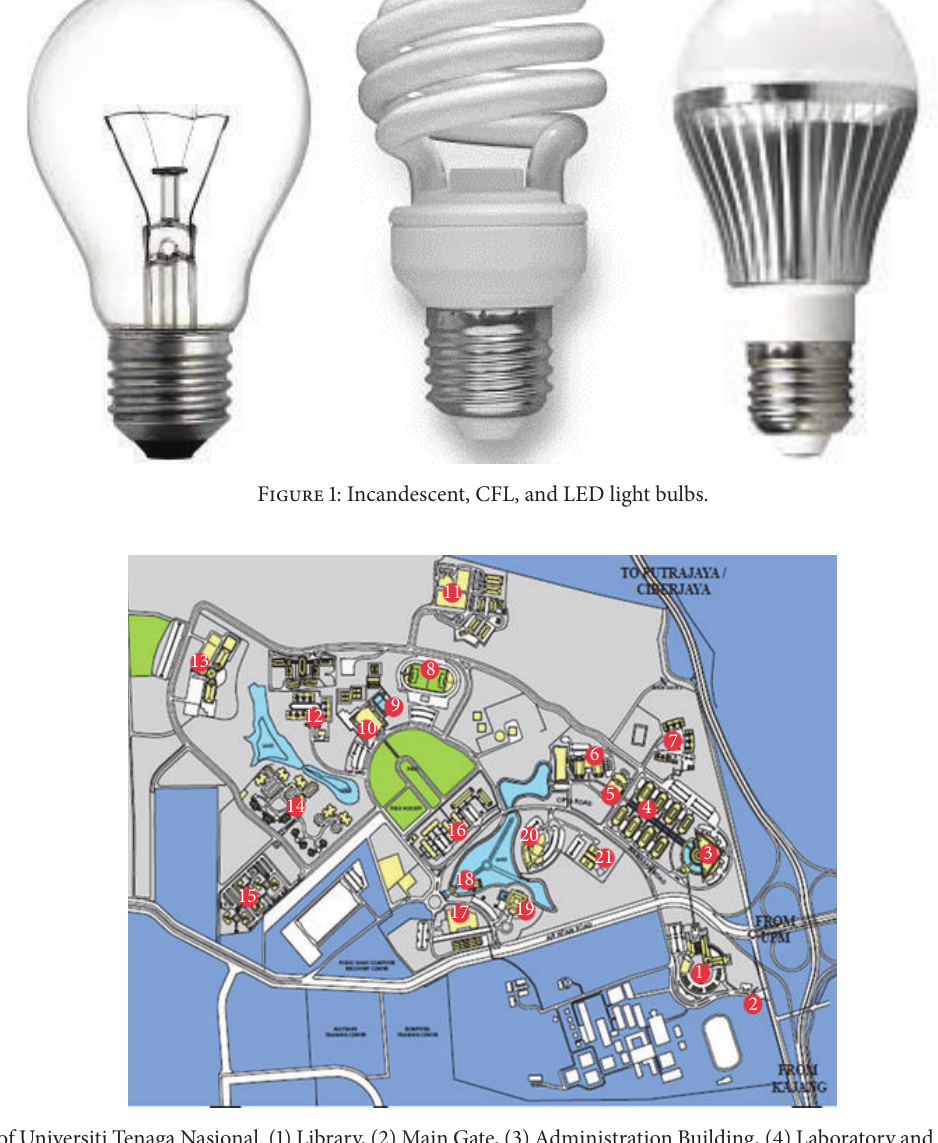
by light bulbs. Figure 2 shows the location of each building in the